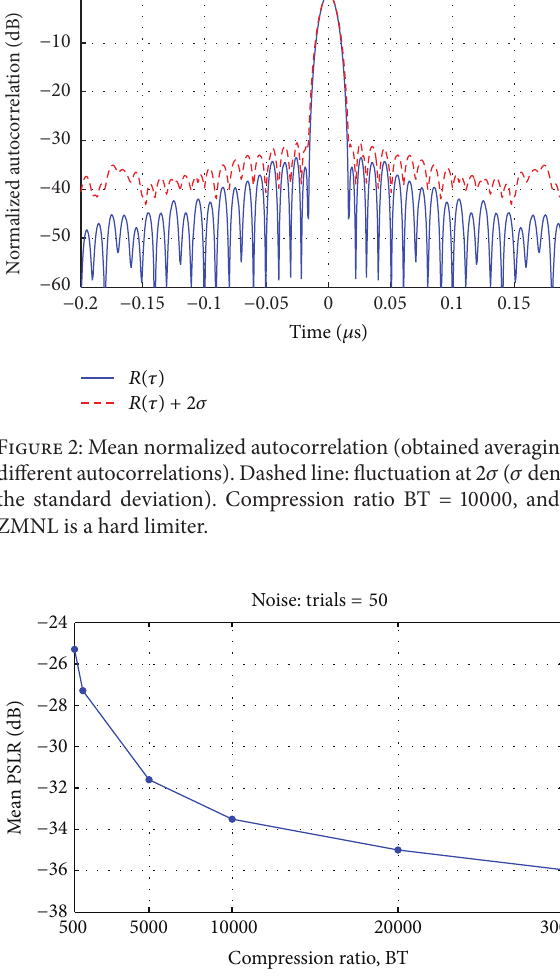
Figure 3: Mean PSLR (obtained averaging 50 different autocorre- lations) versus the compression ratio BT, considering for ZMNL a hard limiter.